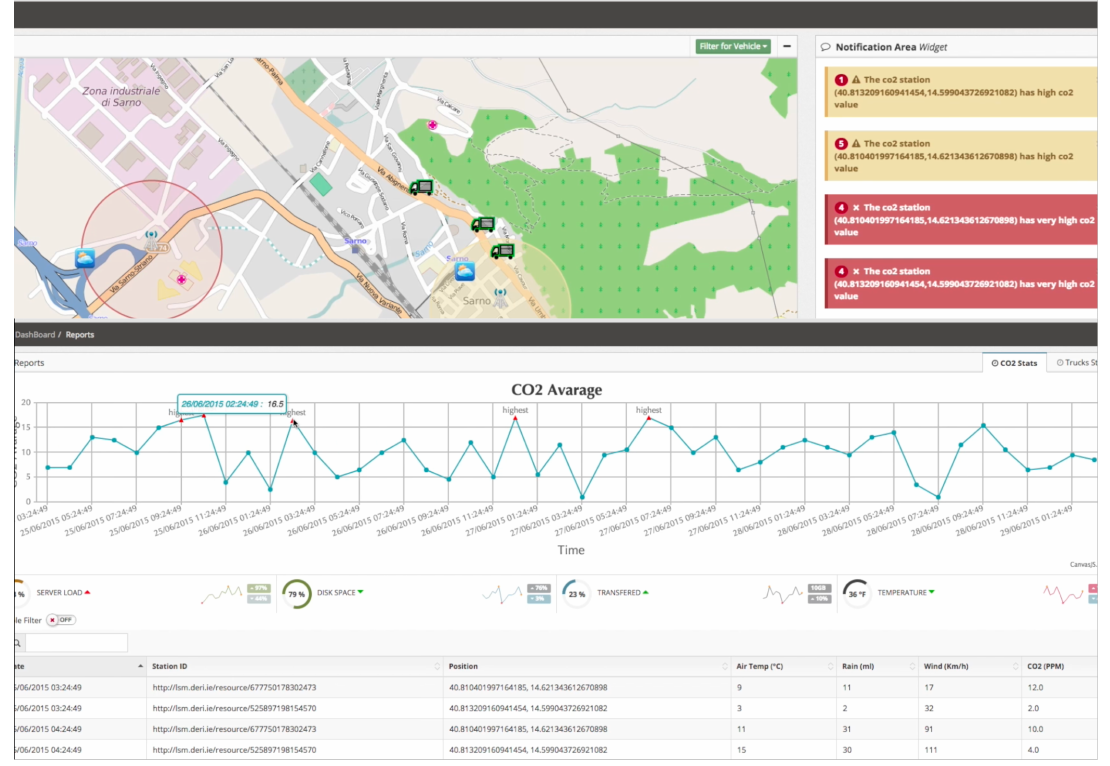
Figure 13. Dashboard of the DSS used for the Situation Awareness Global Assessment Technique (SAGAT) evaluation